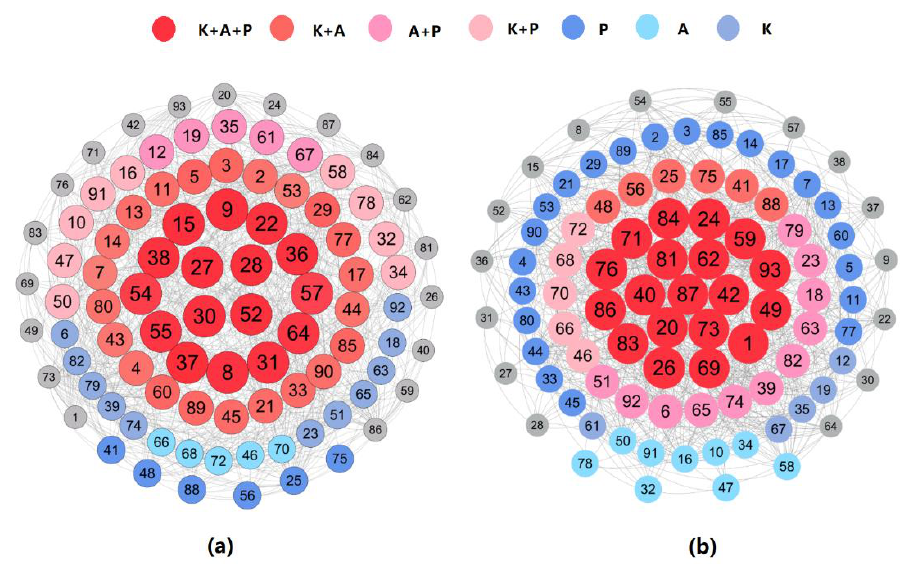
Figure 2. Multi-layer FSW social network. K, knowledge, A, attitudes, P, practices.